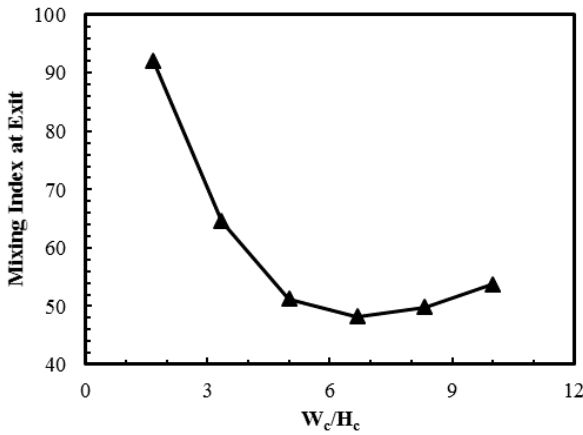
Figure 9. Effect of W c / H c on mixing index at the exit.